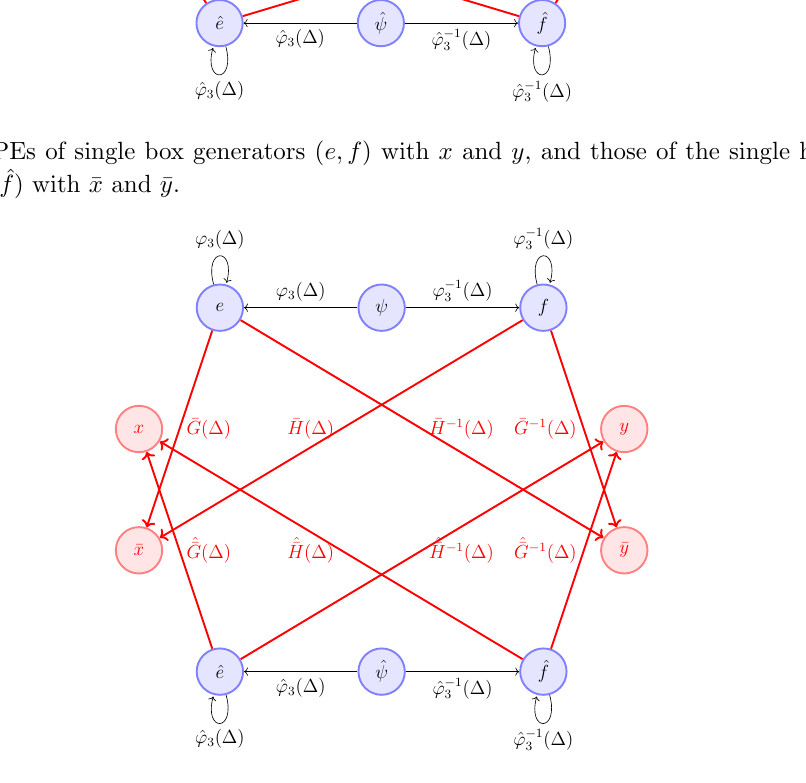
Figure 6 . OPEs of the single box generators ( e; f ) with (cid:22) x and (cid:22) y , and those of the single hatted-box generators (^ e; ^ f ) with x and y